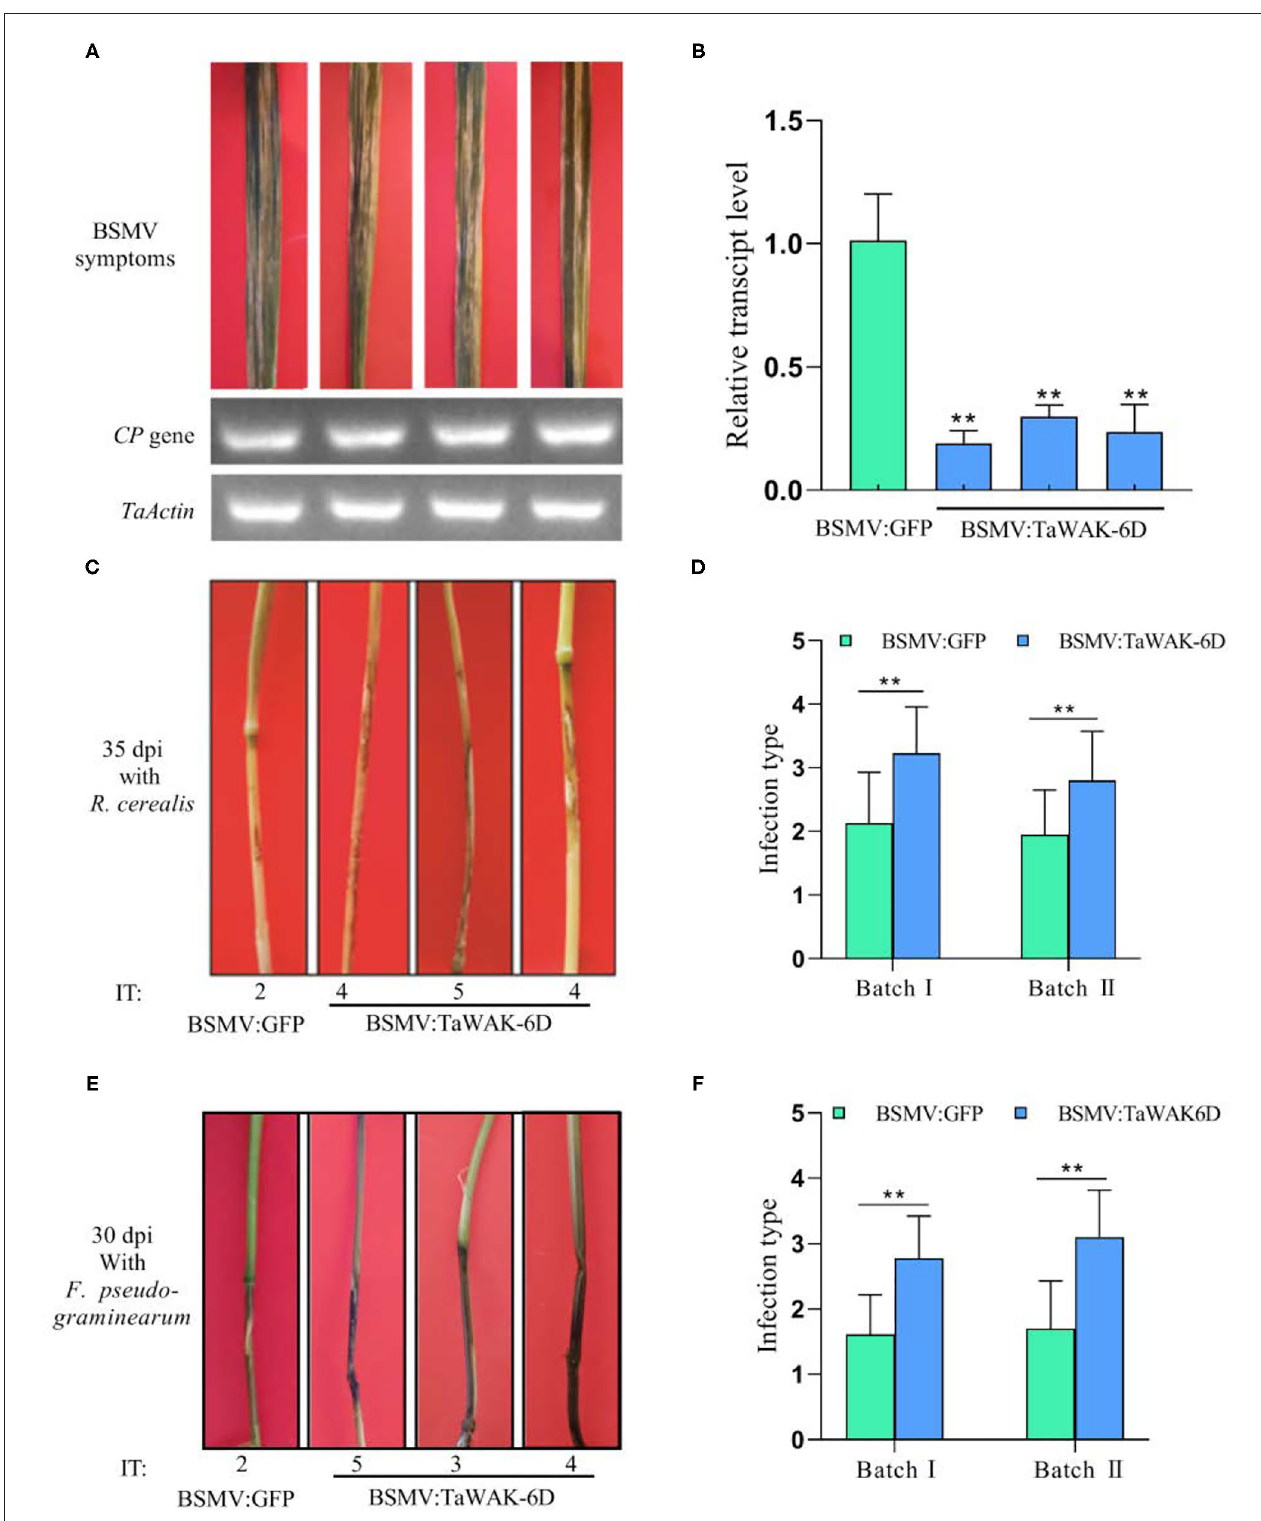
FIGURE 5 | Silencing of TaWAK- 6D increases wheat susceptibility to R. cerealis and F. pseudograminearum . (A) The typical symptom of BSMV on wheat leaves after being infected by BSMV: GFP or BSMV: TaWAK-6D for 15 days. A BSMV coat protein (CP) was used as a marker gene to detect the BSMV. (B) The transcript level